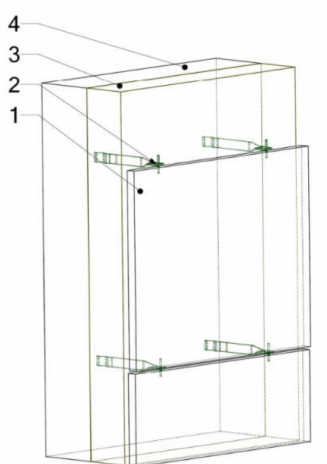
Figure 1. Example of typical fastening system of stone panels using stainless steel anchors: 1. elevation panel, 2. steel anchor, 3. thermal insulation, 4. load-bearing